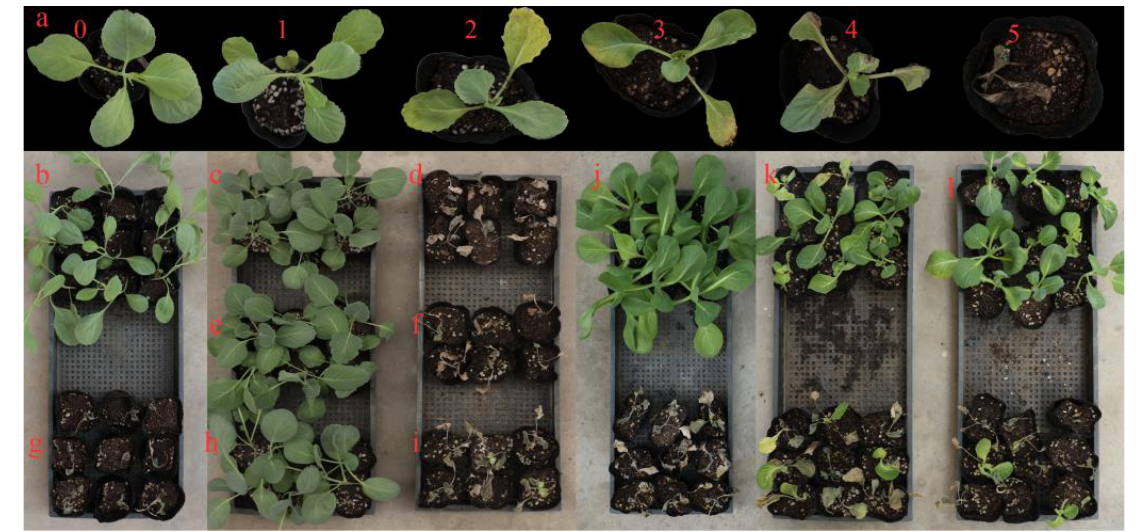
Figure 1. The disease grades of leaves and resistance performance of different materials. ( a ) Disease degrades of levels. 0: no symptoms; 1: slight yellowing of one leaf; 2: moderate yellowing of 1–2 leaves; 3: severe yellowing or wilting of at least half of leaves; 4: severe yellowing or wilting of all leaves other than the core leaves; 5: severe yellowing or wilting of all leaves, or plant death. ( b - i ) resistance performance of different materials to race 2. ( b ) ‘BI-16’ (resistant control). ( c ) ‘HB1186’. ( d ) ‘21-3’. ( e ) ‘YF’. ( f ) ‘23202’. ( g ) ‘01-20’ (susceptible control). ( h ) ‘XQ’. ( i ) ‘01-88’. ( j – l ) The same materials were resistant to race 1 while susceptible to race 2. ( j ) ‘JTM’. ( k ) ‘CF3’. ( l ) ‘MYF’.